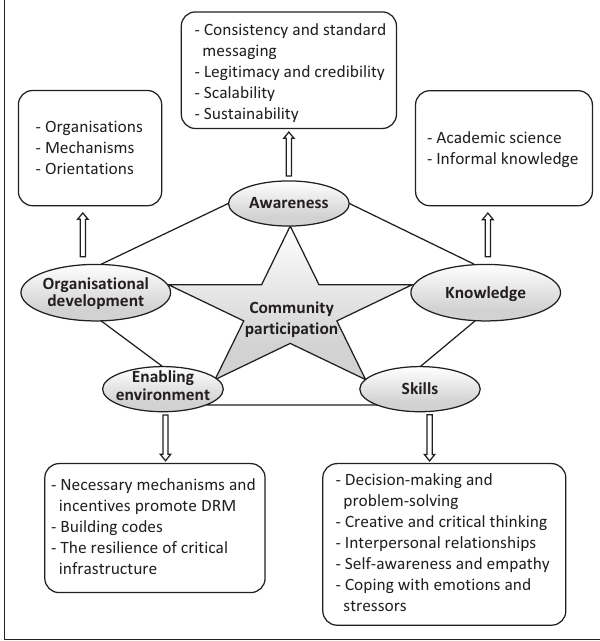
FIGURE 2: Participation and risk management cycle.